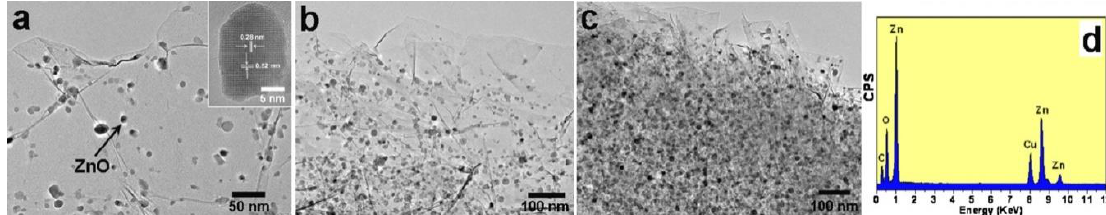
Figure 57. TEM images of as-prepared rGO/ZnO nanohybrids obtained with different concentrations of Zn 2 + : ( a ) 0.0023 M, ( b ) 0.0069 M and ( c ) 0.0115 M, ( d ) EDS pattern of the rGO / ZnO nanohybrids.